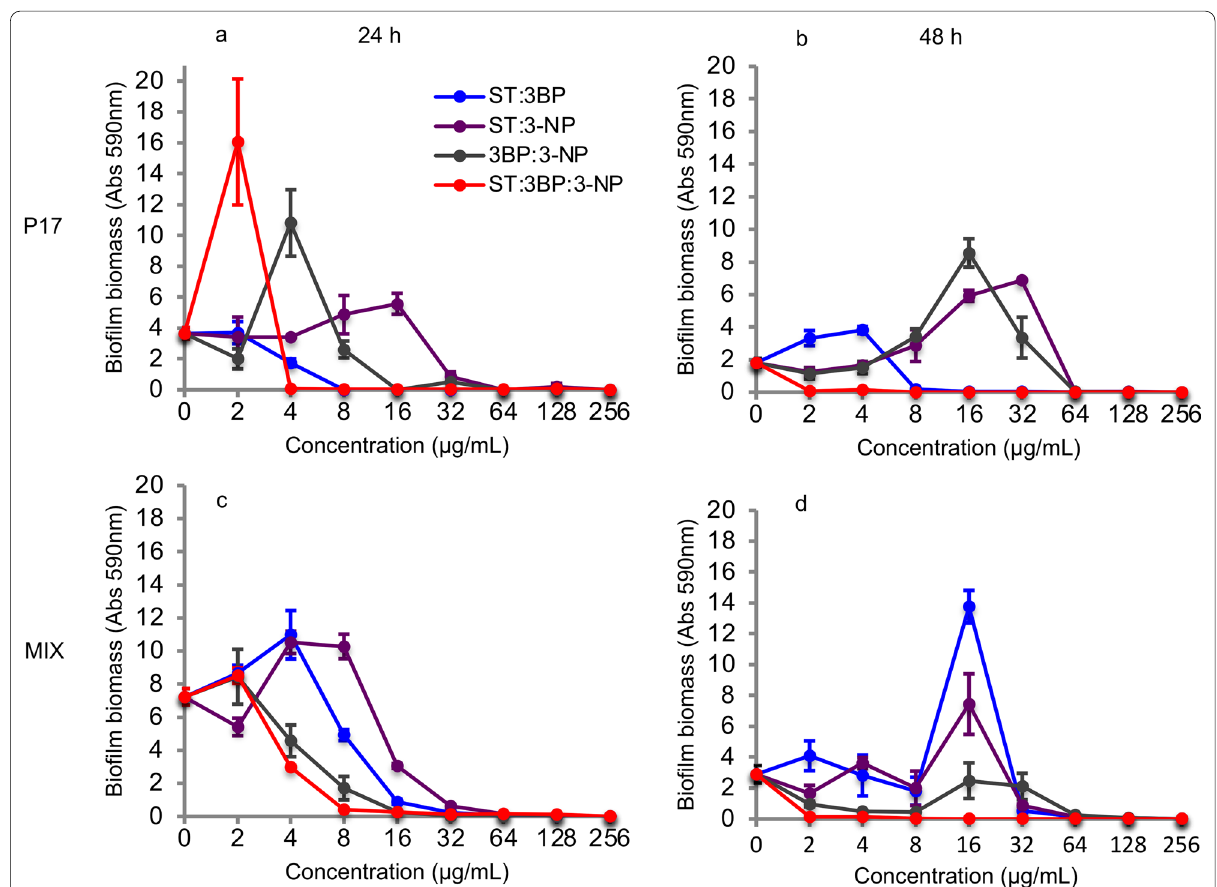
Fig. 5 Biofilm formation of P17 and four species (MIX) cultures with combined metabolic inhibitors after 24 and 48 h. a Biofilm formation of P17 culture with combined metabolic inhibitors (24 h). b Biofilm formation of P17 culture with combined metabolic inhibitors (48 h). c Biofilm formation of four species culture with combined metabolic inhibitors (24 h). d Biofilm formation of four species culture with combined metabolic inhibitors (48 h). ST: sulfathiazole, 3BP: 3-bromopyruvic acid, and 3-NP: 3-nitropropionic acid, n =